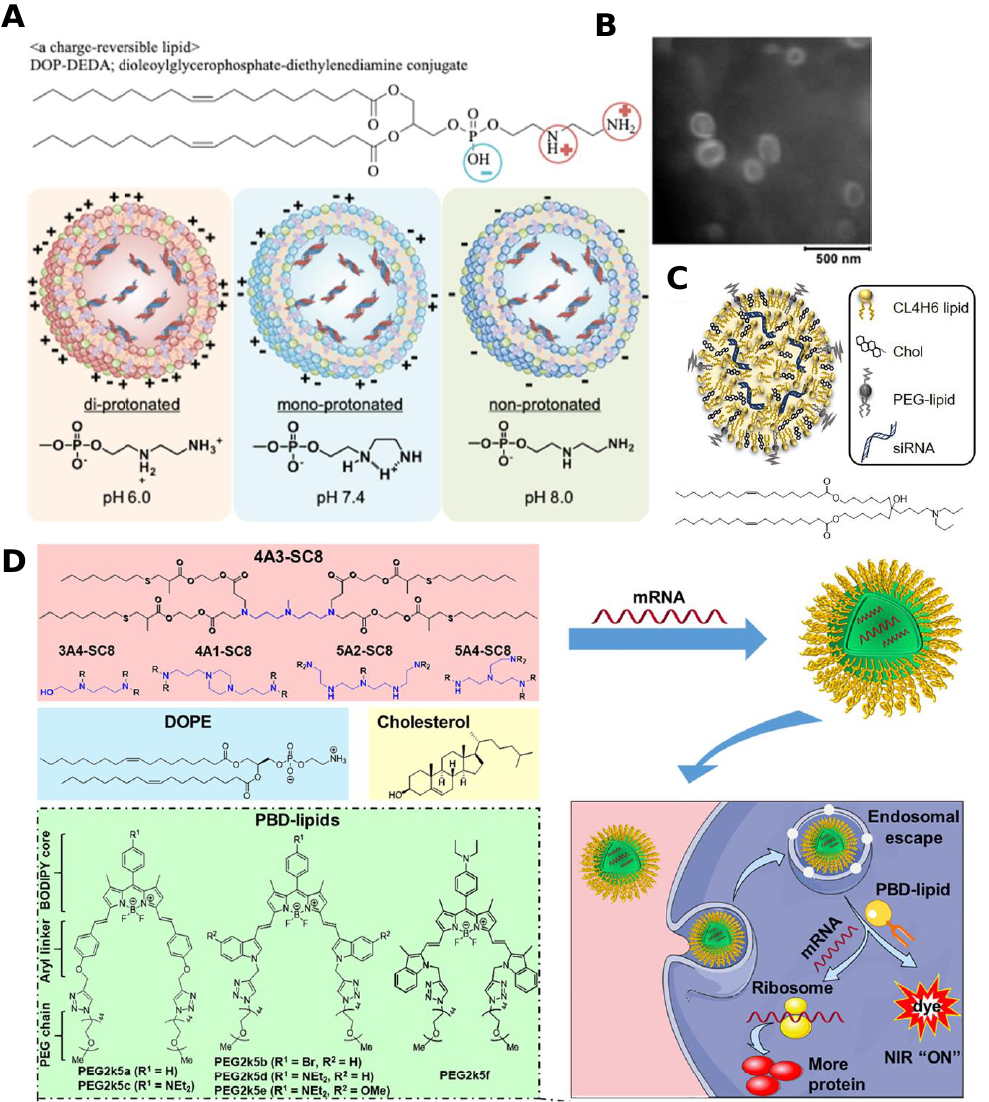
Figure 6. ( A ) Schematic diagram of the DOP-DEDA structure and pH response of DOP-DEDA LNPs, and TEM image ( B ) of DOP-DEDA LNP. Dop-deda has a negatively charged phosphate and two amino groups linked by an ethylene bridge. Produces an almost neutral charge at pH 7.4. The total positive charge at pH = 6.0 and the total negative charge at pH = 8.0 [106]. Copyright 2020, Elsevier. ( C ) LNPs nanostructure and CL4H6 lipid chemical structure. LNP is composed of CL4H6 lipids, CHOL and PEG-lipids [107]. Copyright 2020, Elsevier. ( D ) Schematic representation of den- drimer/DOPE/cholesterol/PBD-lipid/mRNA nanoparticles and mRNA delivery process. The com- bination of PDB lipids and DLNP enhances mRNA production in cancer cells, illuminating tumors by PH-responsive NIR imaging [108]. Copyright 2020, Elsevier.